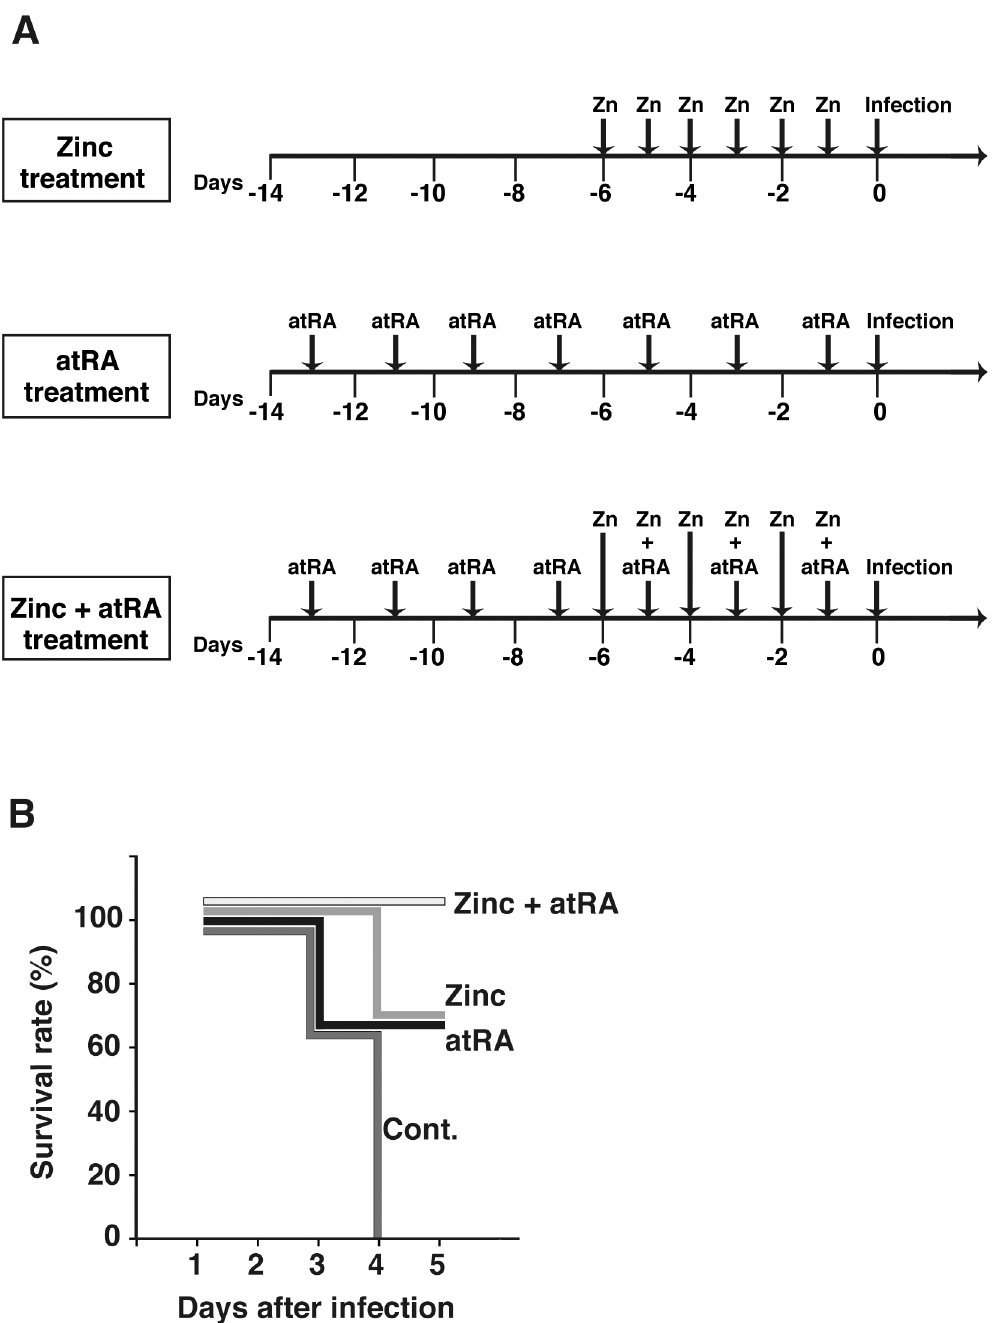
Fig 1. Survival of lethally infected mice supplemented with Zn and atRA. Panel A shows the administration procedure. At the end of atRA and Zn administration, mice were inoculated intravenously with 10 5 /100 μ l L . monocytogenes per animal. Groups of four mice per compound were checked daily for survival. Survival was observed until day 5